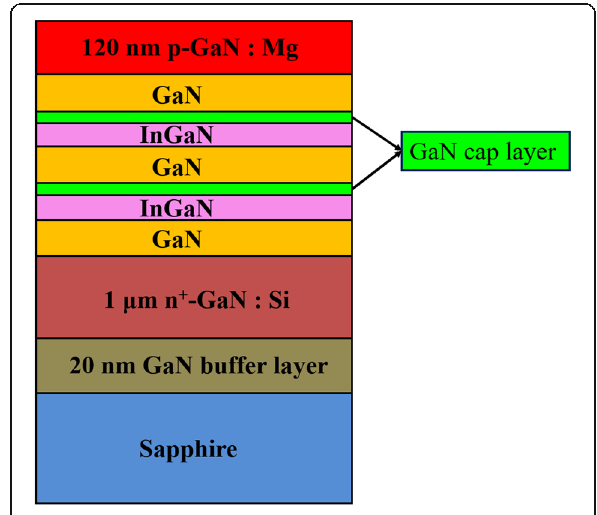
Fig. 1 The cross-sectional schematic diagram of the epilayer structures of two